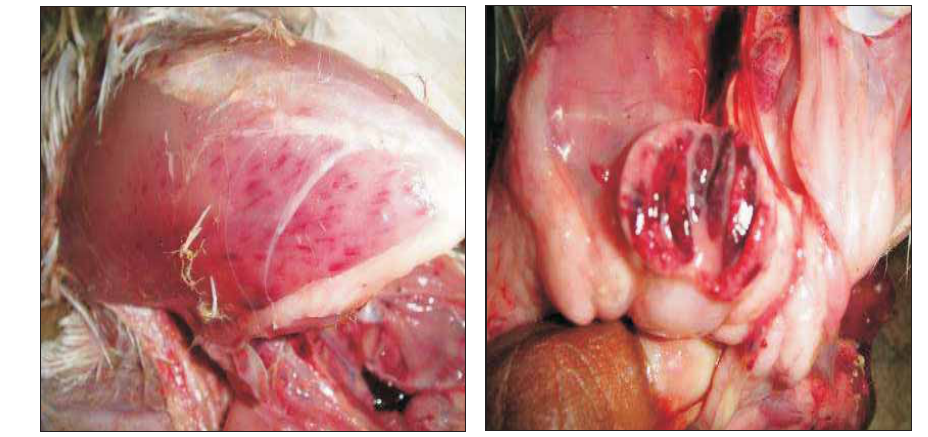
Figure-1a: Hemorrhages on chest muscles Figure-1b: Enlarged hemorrhagic